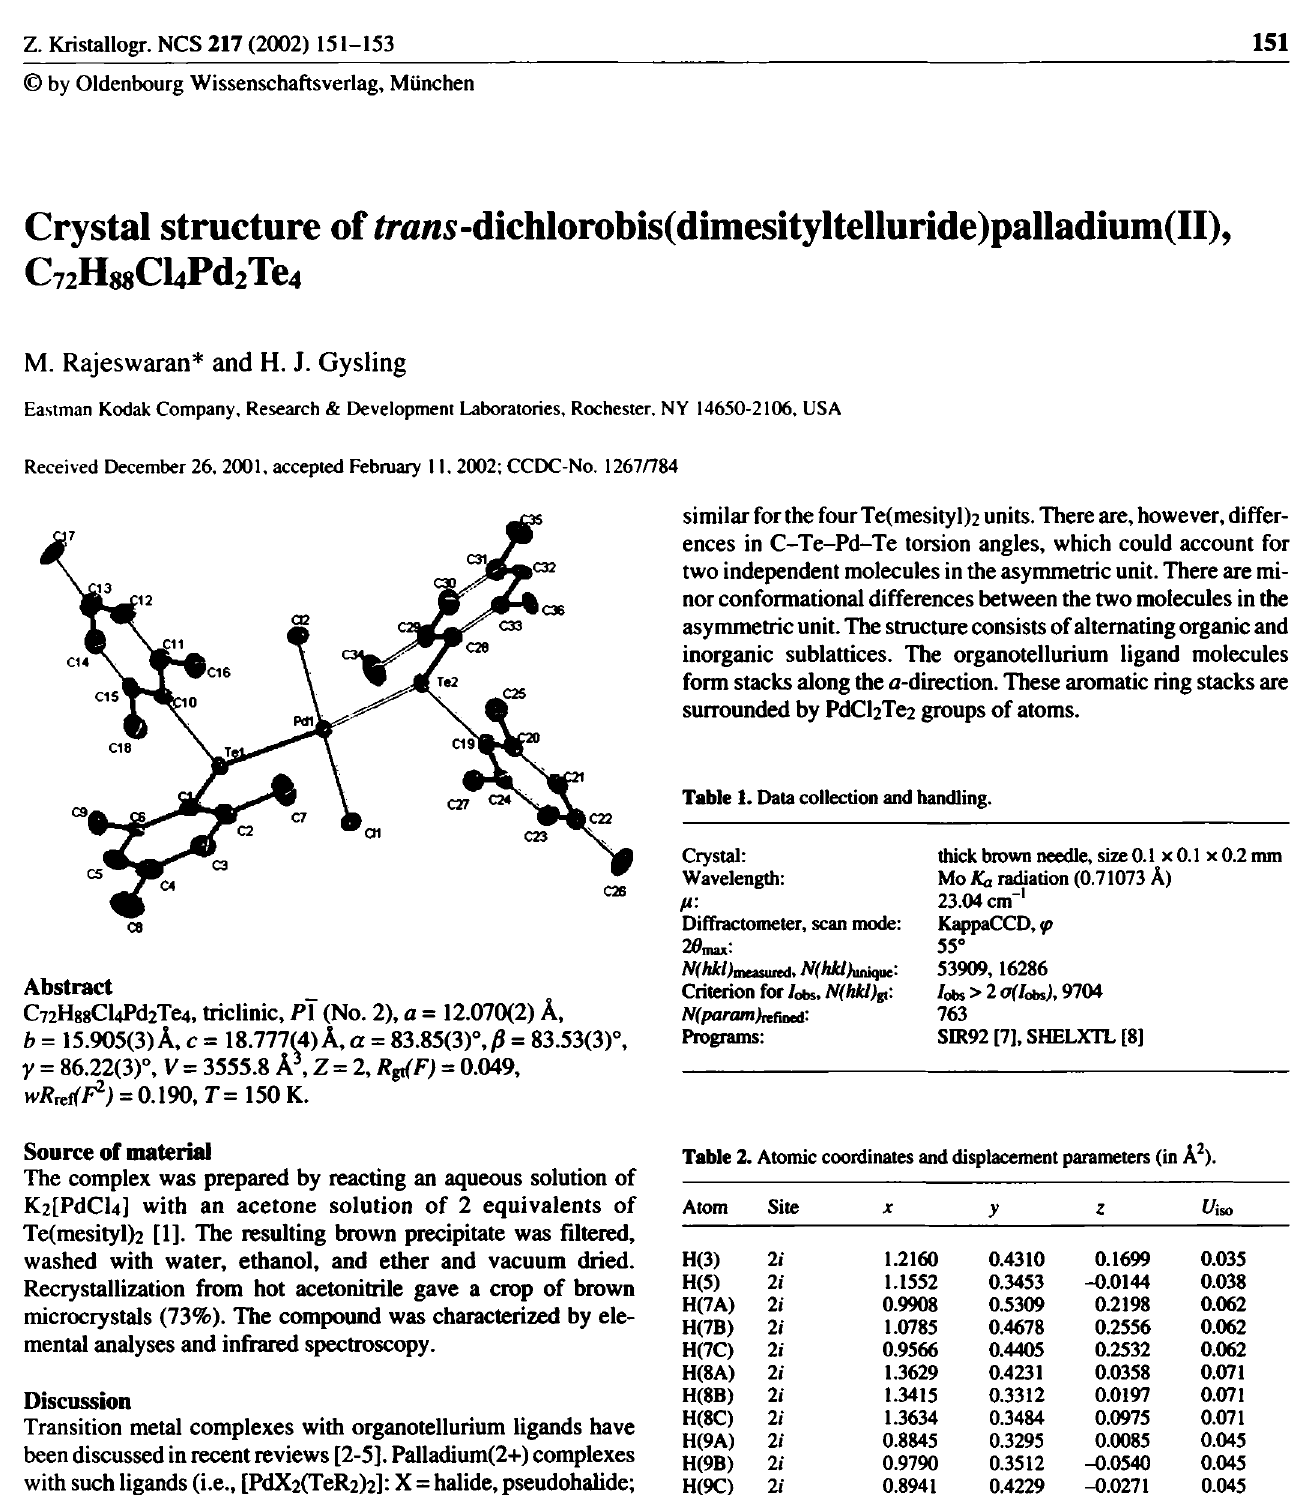
Table 2. Atomic coordinates and displacement parameters (in A 2